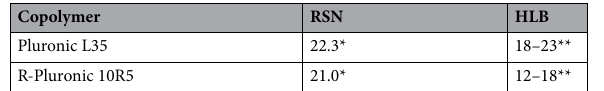
Table 1. RSN and HLB values of Pluronic L35 and R-Pluronic 10R5. *ref. 33 ; **ref. 34 .